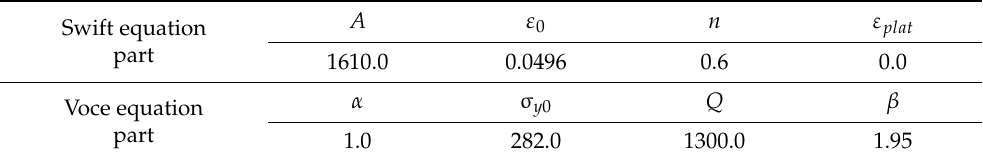
Figure 6. Flow stress of 304L stainless steel. Experimental results with engineering stress-strain relation are valid until the onset of the diffuse neck. In the domain of diffuse neck, the true stress is estimated through Swift equation and Voce equation. Table 2. Material parameters of 304L stainless steel. In this study, 304L stainless steel did not show a yield plateau, so the yield plateau was set to zero.